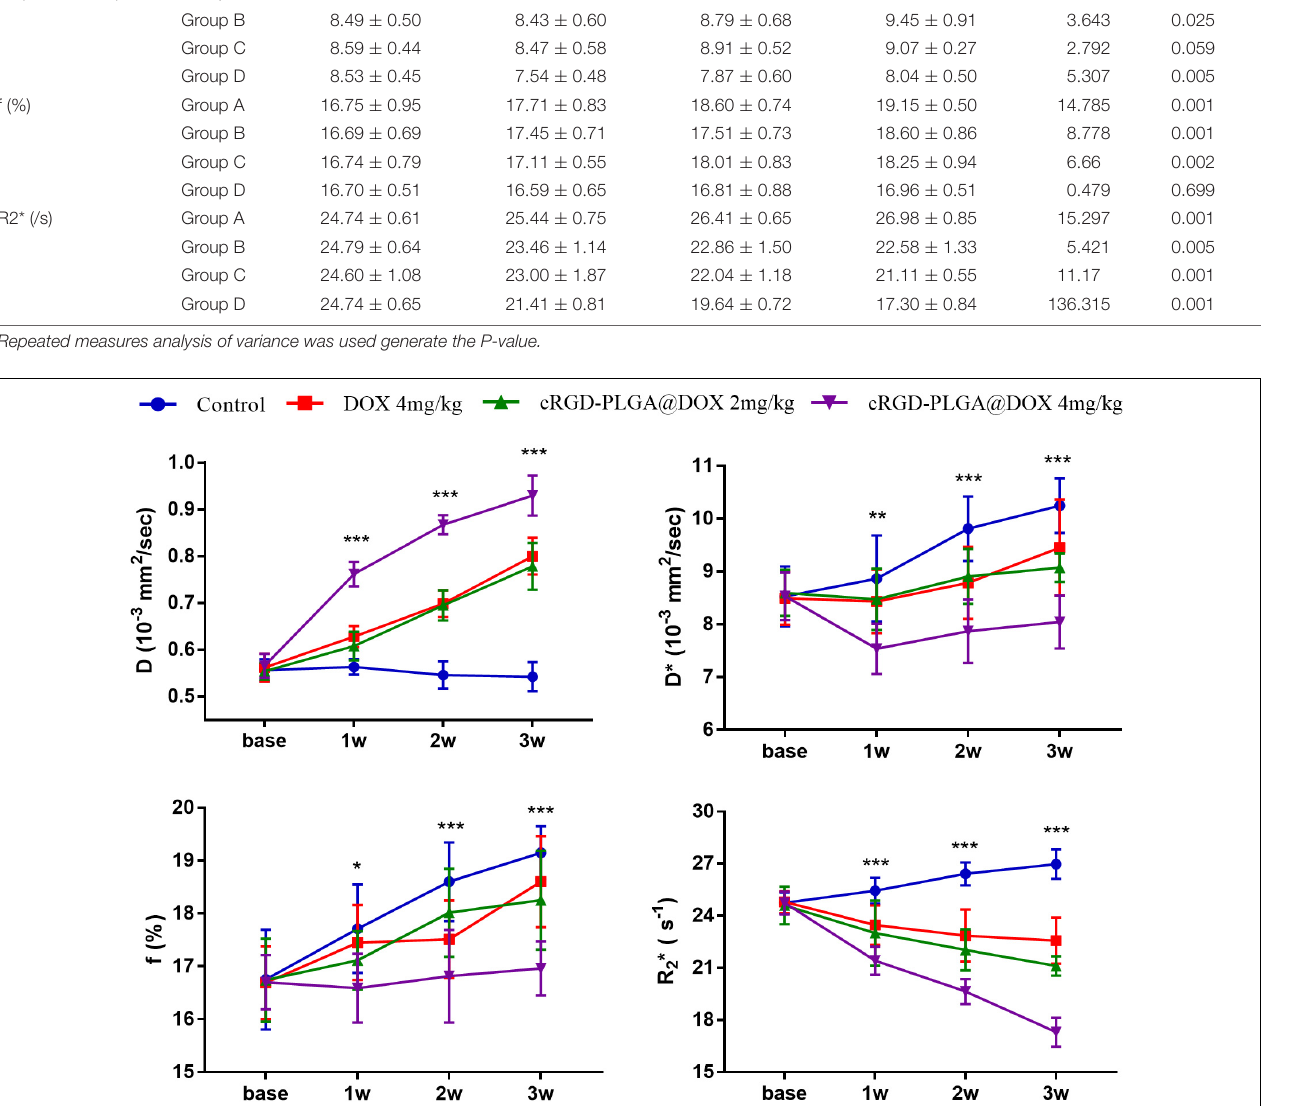
but inversely correlated with D value ( r = − 0.757, P < 0.001). In assessing cell apoptosis, TUNEL staining was only positively correlated with D value ( r = 0.621, P < 0.001). PTEN staining was positively correlated with both D ( r = 0.57, P = 0.004) and f values ( r = 0.428, P = 0.037), but their associated strengths were weak to